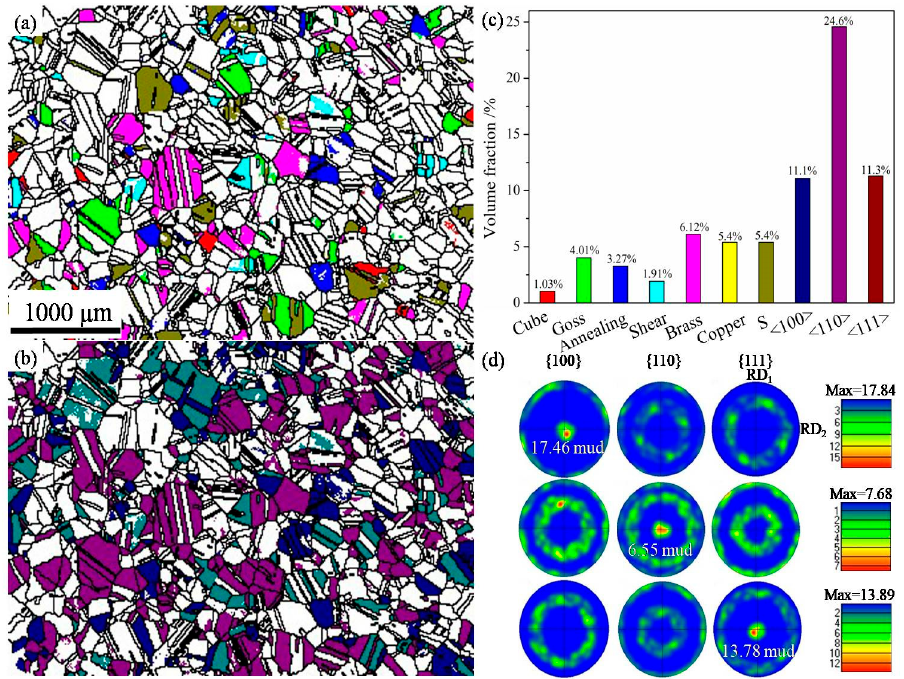
Figure 3. Characterization of the texture of the as-received sample: ( a , b ) texture components map; ( c ) statistics of texture; and ( d ) pole figure of fiber texture.